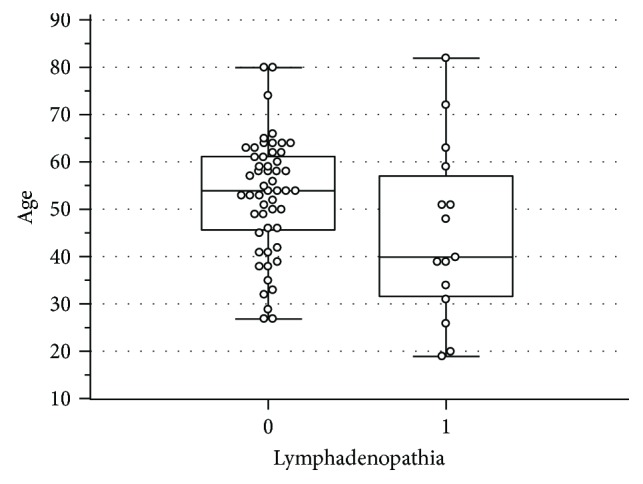
Correlation between the age of pSS patients and lymphadenopathy.